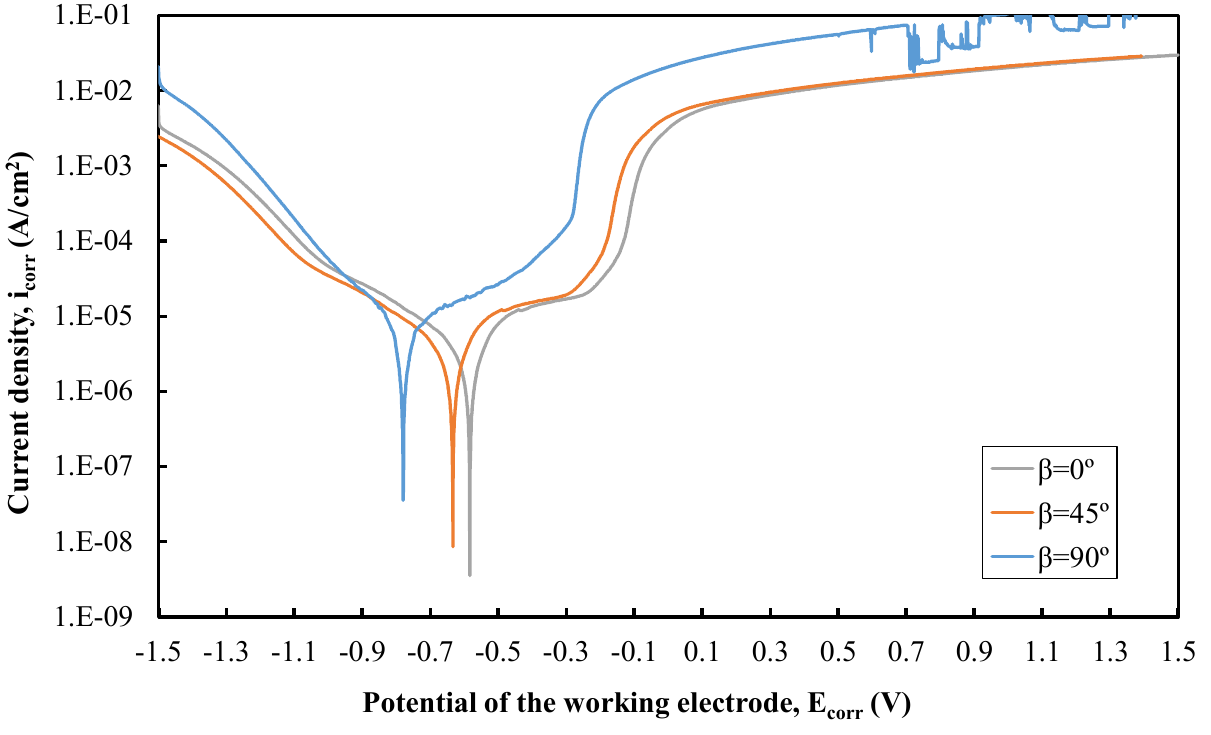
Potential of the working electrode, E (V) corr Figure 8. Potentiodynamic polarization curves: Static test. In order to justify the previous affirmation, Table 2 presents different crack closure levels for each series with respective stress intensity factor range ( ∆ K). When we compared the values of U = 0.815 for β = 0 ◦ , U = 0.8445 for β = 45 ◦ and U = 0.817 for β = 90 ◦ in air conditioning with the U values on ∆ K = 18 and 25 MPam 0.5 (Table 2) for the fatigue under saline corrosion, we verified a lower U value for fatigue under saline corrosion. However, for ∆ K = 40 MPam 0.5 the deposition planes β = 0 ◦ and β = 45 ◦ showed similar U values to the average U values registered in air conditioning. Table 2. Crack closure levels for each series as a function of ∆ K (MPam 0.5 ) under saline corrosion.